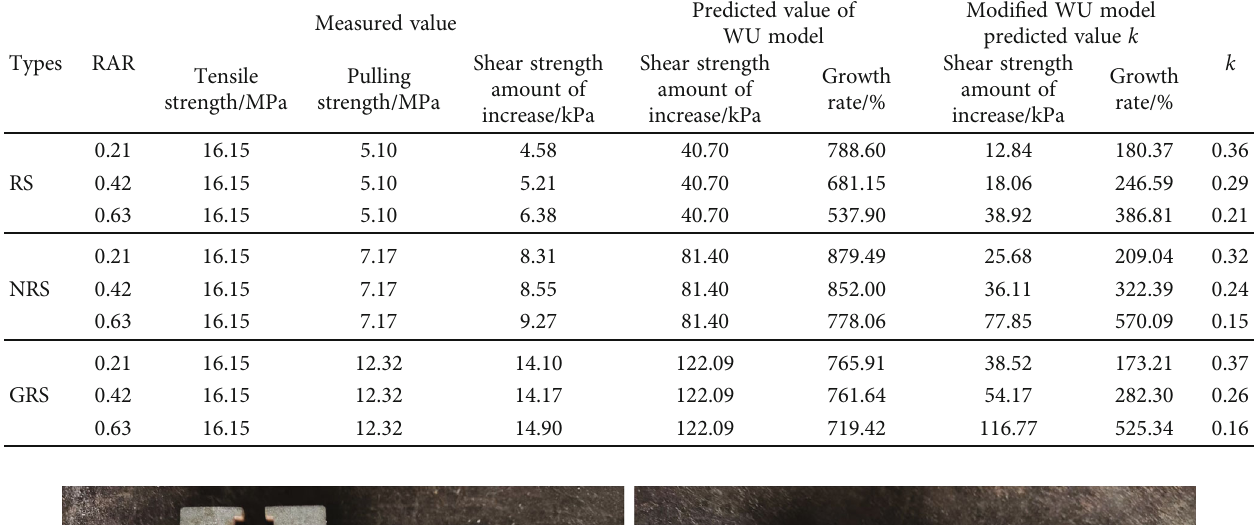
Table 6: Calculation results of measured value and model value of root additional cohesion.